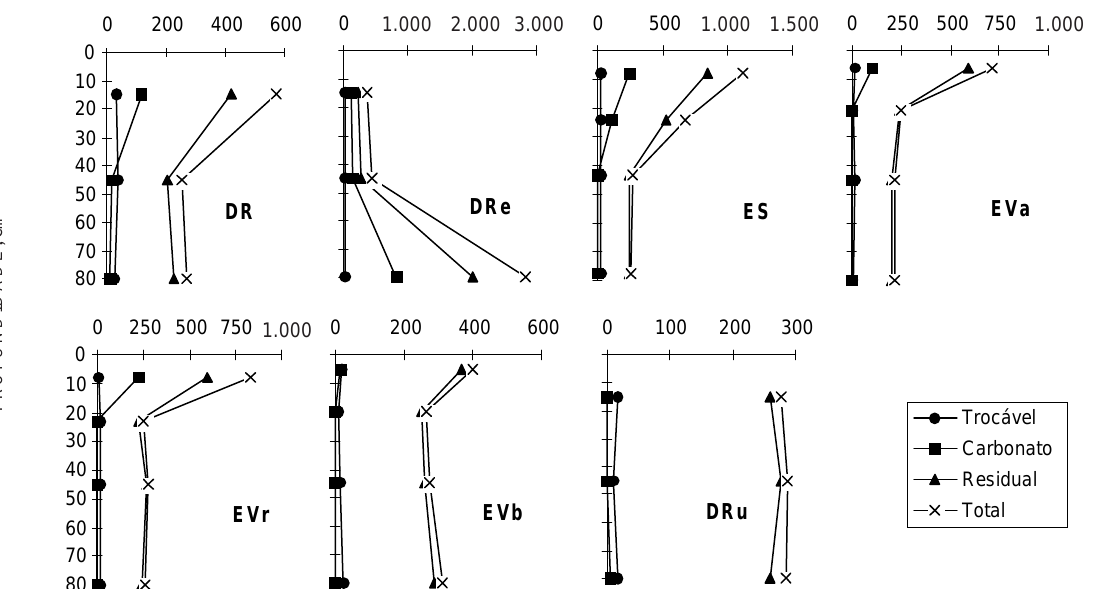
Figura 5. Formas químicas e teores de Pb no solo nos diversos locais e profundidades amostradas. Legenda: ver figura